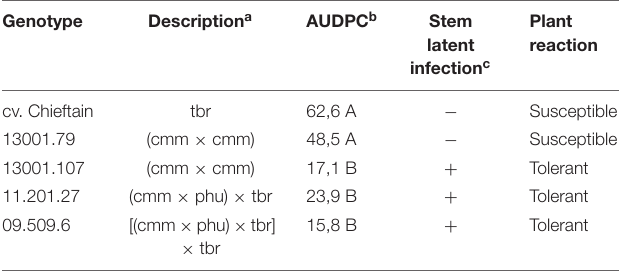
TABLE 1 | Bacterial wilt responses of selected potato genotypes expressed as the area under disease progress curve (AUDPC) and pathogen detection in stem tissues of asymptomatic plants 28 days post